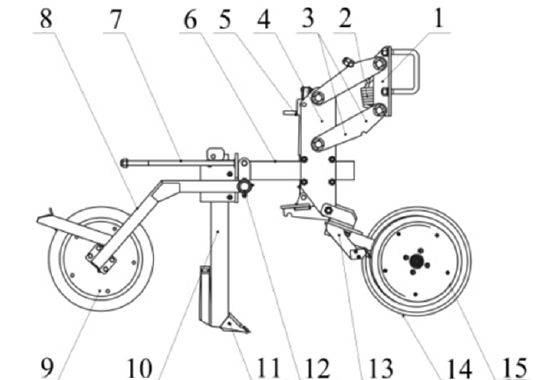
Figure 1. The sowing section (1 - parallelogram suspen– sion mechanism; 2 - spring; 3 – top and bottom links of the parallelogram suspension; 4 - section body; 5 - depth adj– ustter; 6 – plough beam; 7 - spring of the press wheel; 8 – press wheel bracket; 9 – press wheel; 10 - colter rack; 11 - colter; 12 - hinge to fasten the press wheel bracket; 13 - balancing wheel bracket; 14 - slotting disk; 15 - balancing wheel)